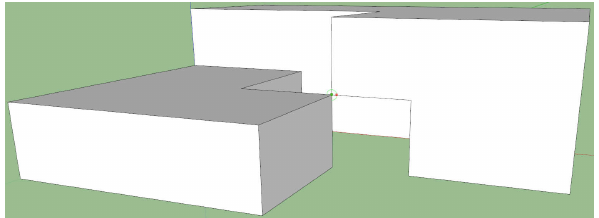
Figure 19:Topological error caused by a non-manifold